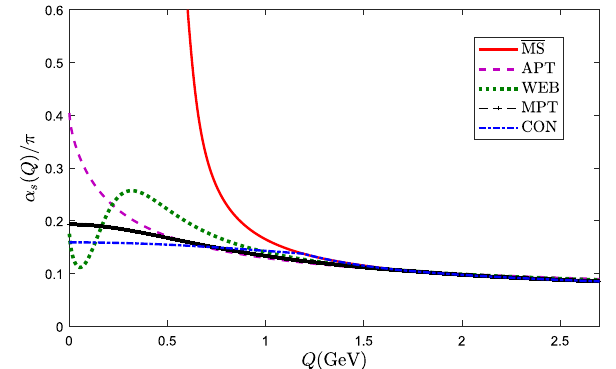
Fig. 1 Typical α s -running behavior in low-energy scales for four typ- ical low-energy models, APT, WEB, MPT, and CON, respectively. The α s -running behavior derived from RGE under MS-scheme is given as a